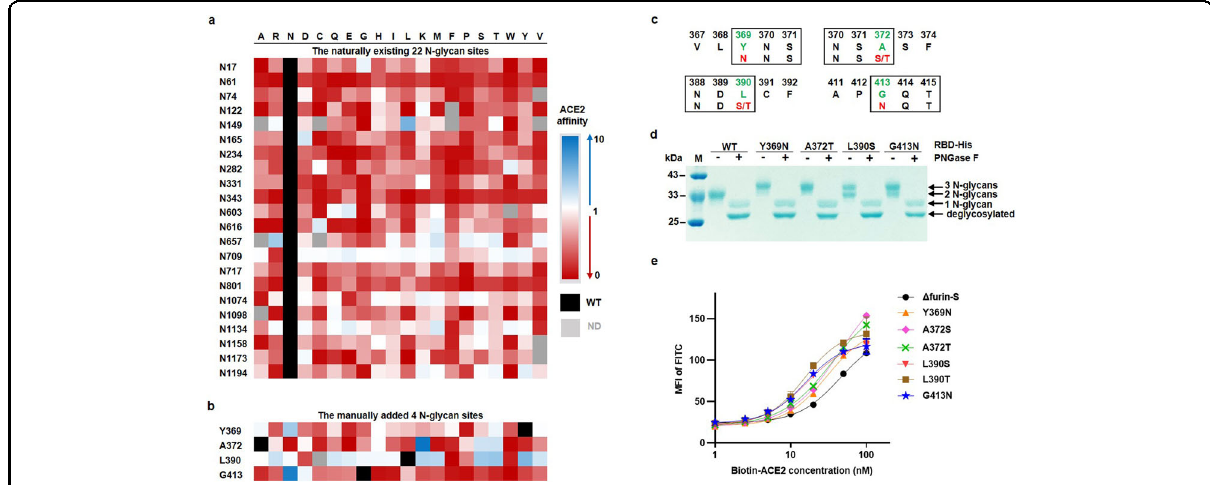
Fig. 3 Characterization of naturally existing and manually added N -glycan sites. a The heatmap of 22 naturally existing N -glycan sites, in which the original asparagine (N) residues, ND mutational types were colored in black and gray, respectively. b The heatmap of 4 manually added N -glycan sites, in which the original tyrosine (Y) of 369, alanine (A) of 372, leucine (L) of 390, glycine (G) of 413 residues and ND mutational types were colored in black and gray, respectively. c The sequence motif of 4 manually added N -glycan sites (black rectangle), which was generated by the substitution of the original residue (green letter) to the novel residue (red letter). d The PNGase F treatment of His-tagged RBD variants. The predicted MW of three N -glycans, two N -glycans, one N -glycan, and zero N -glycan (deglycosylated) isoform was 39 kDa, 35 kDa, 31 kDa, and 27 kDa, respectively. e The ACE2 titration curves of Δ furin-S and six manually added N -glycan S variants cell lines (Y369N, A372S/T, L390S/T, and